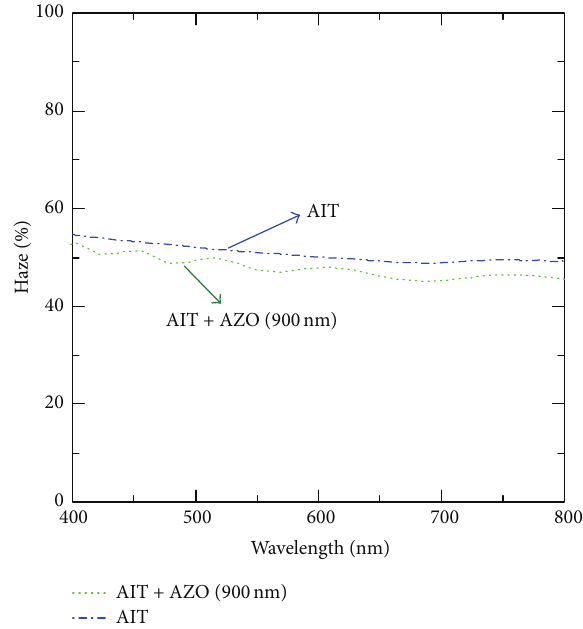
Figure 4: Measured haze of the AIT superstrate sample before and after the deposition of a 900 nm thick AZO